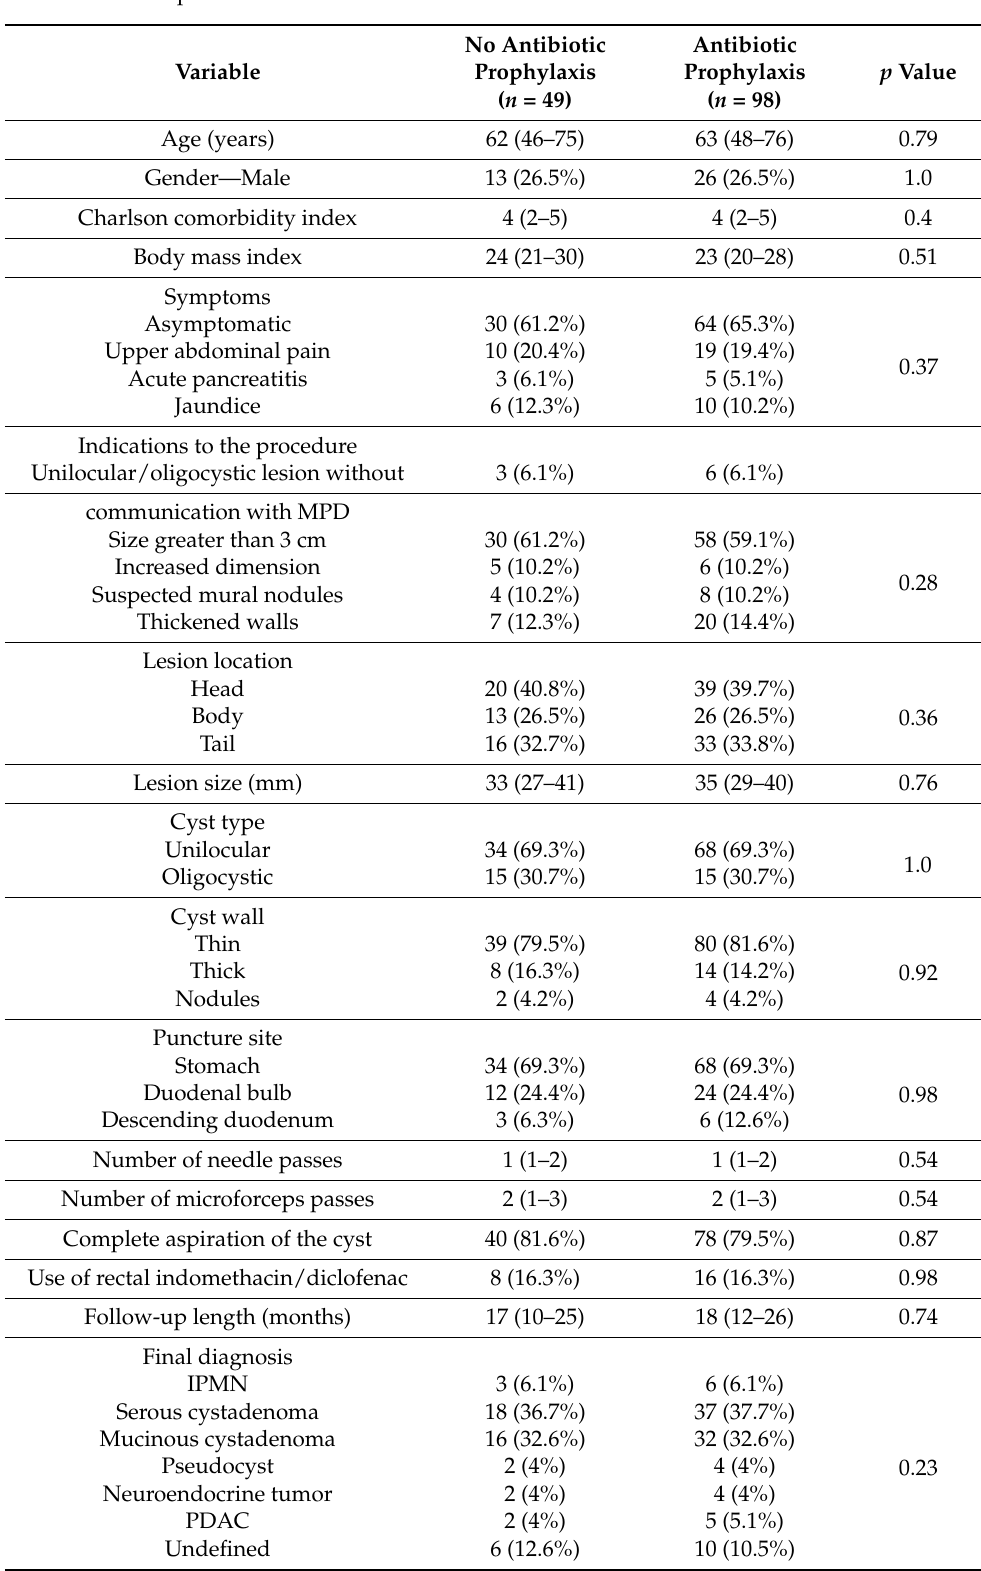
Table 1. Baseline patient